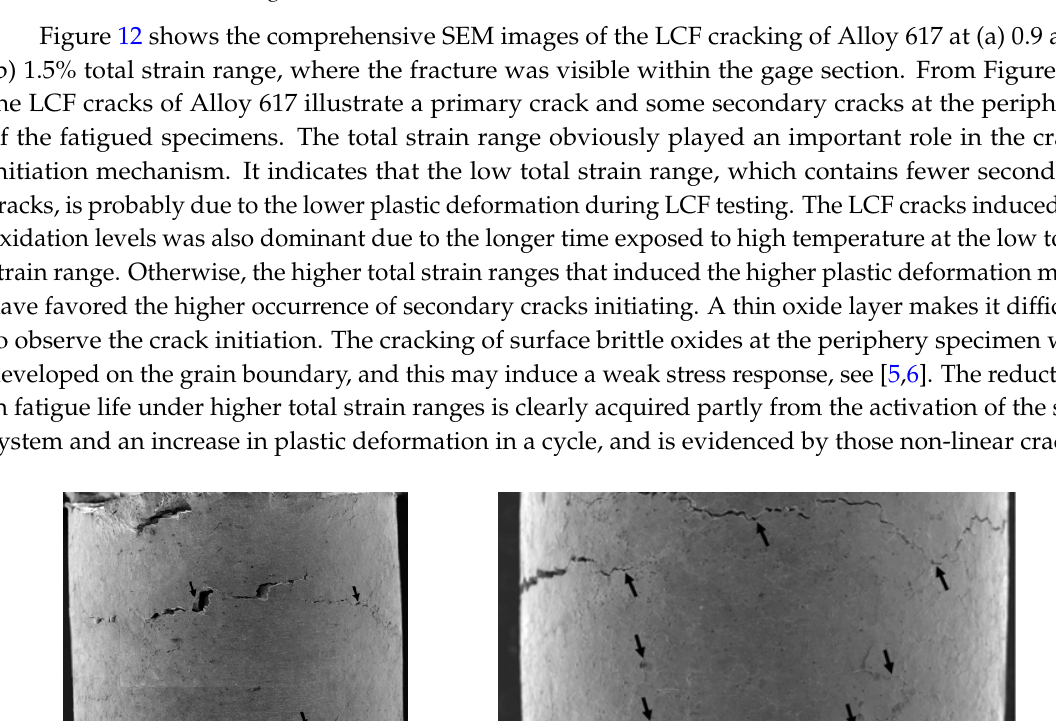
Figure 11. Fatigue life curves based on total and plastic strain energy dissipated per cycle of Alloy 617 at the 950 °C condition.